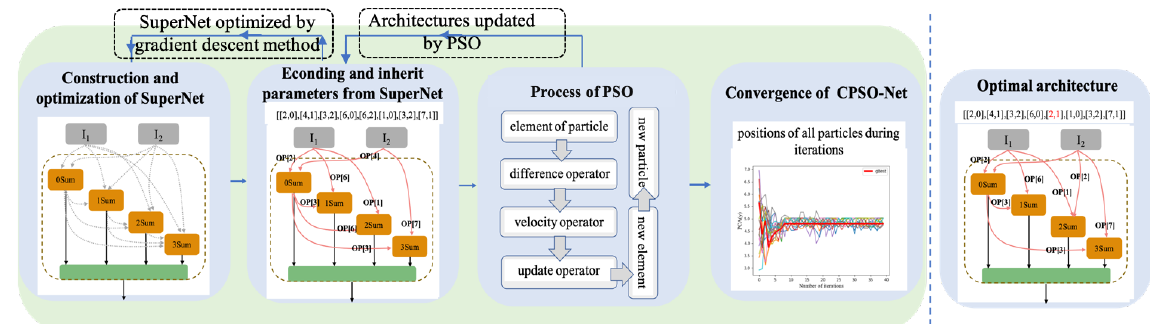
Figure 2. Framework of CPSO-Net. A continuous SuperNet that contains all candidate operations and can be trained by gradient descent is maintained first. Then, all architectures are encoded into an array, inheriting the parameters from the SuperNet, and search for the optimal architecture by PSO. Finally, the optimal architecture is